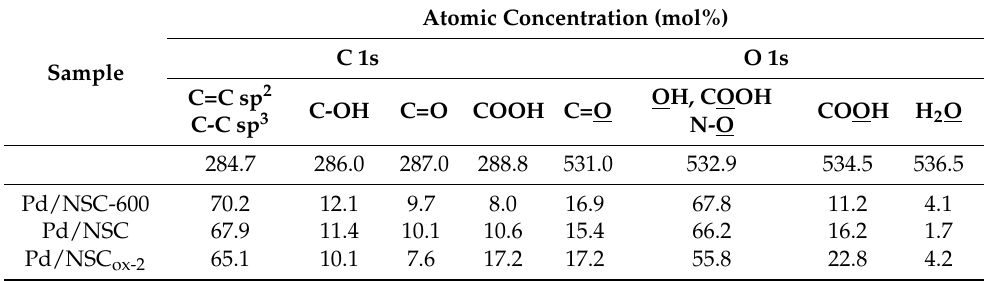
Figure 9. High-resolution XPS data of Pd/NSC-600, Pd/NSC, and Pd/NSC ox-2 catalysts: C 1s ( a ), O 1s ( b ) and Pd 3d ( c ). Table 4. Surface carbon and oxygen concentrations of the various